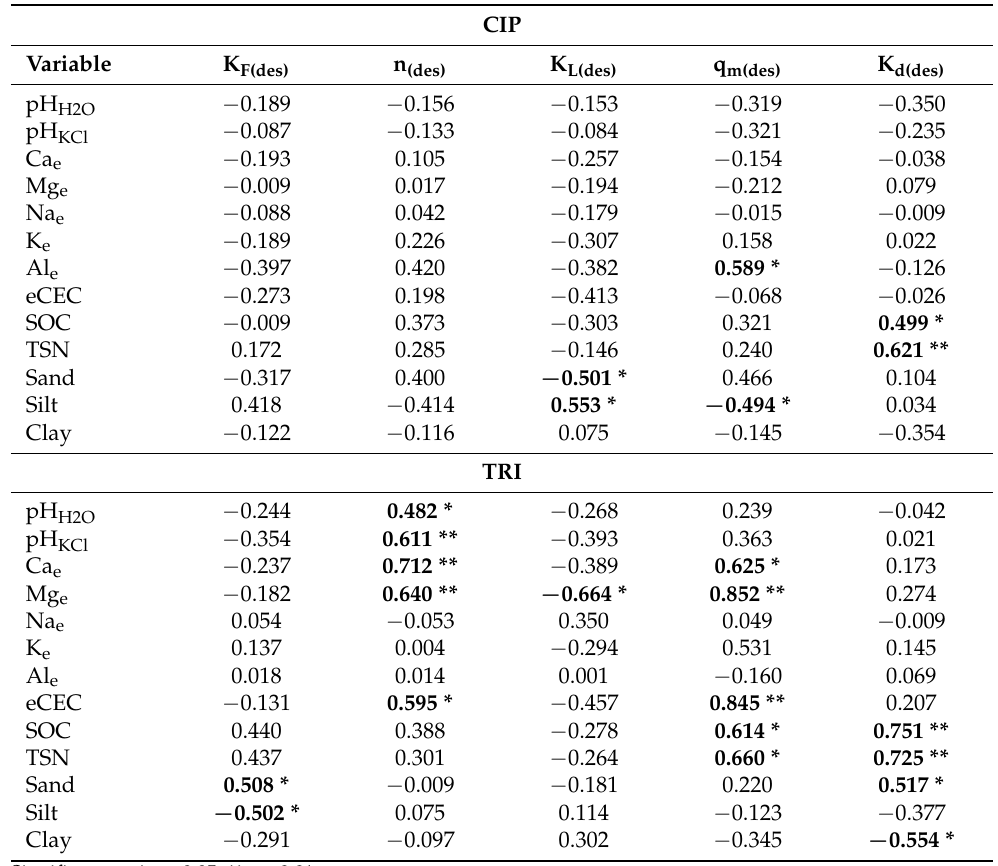
Table 8. Relations among desorption parameters for ciprofloxacin (CIP) and trimethoprim (TRI)